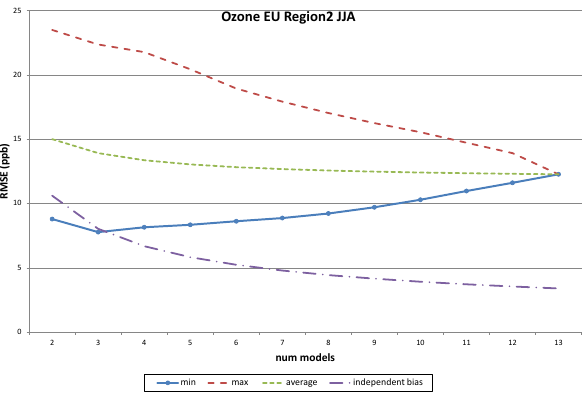
Fig. 8. Curves of maximum, mean and minimum RMSE for ozone in EU region 2. The curves are obtained by calculating the mean of randomly sampled subsets of models as a function of m , the dimen- sion of the subsets. The theoretical decay that would occur if the model errors were independent, ∼ m − 0 . 5 , is also